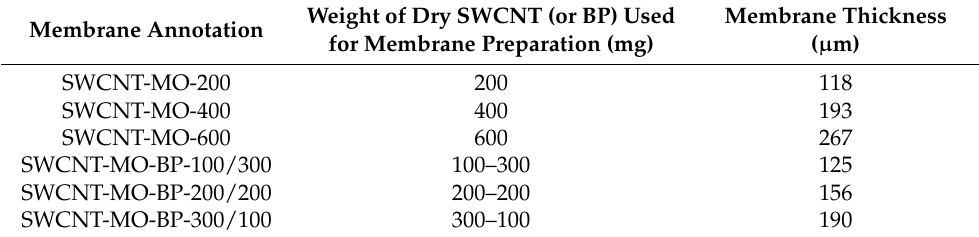
Table 2. Prepared mildly oxidized SWCNT